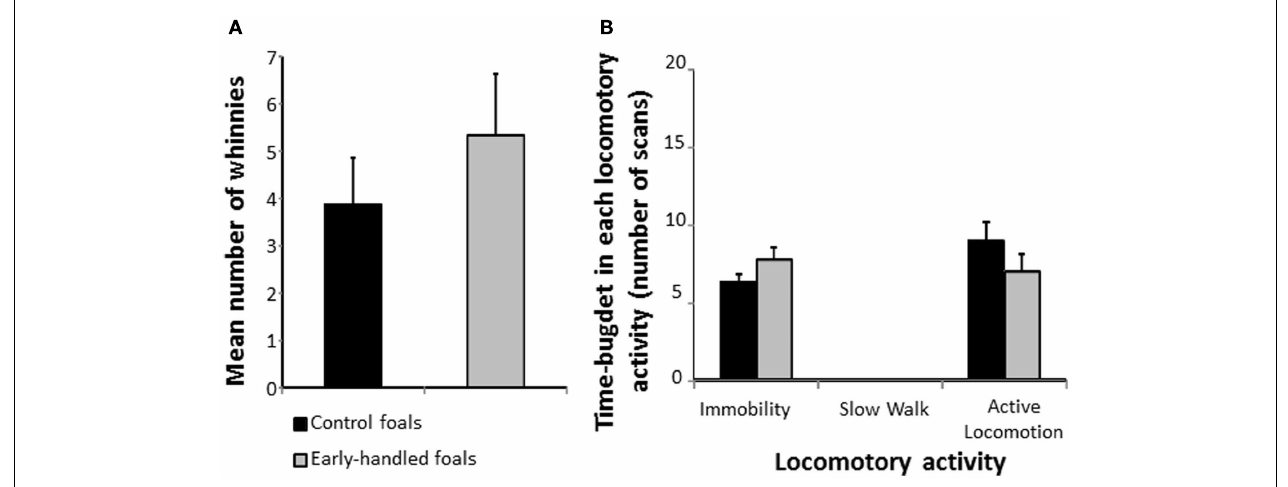
FIGURE 1 | Behaviors of 1-year-old, early handled, and unhandled foals during social separation. Foals were left alone in their familiar stall. (A) Mean number ( ± SEM) of whinnies emitted during the experiments; (B) mean number ( ± SEM) of scans when the foals performed different types of locomotor activity.